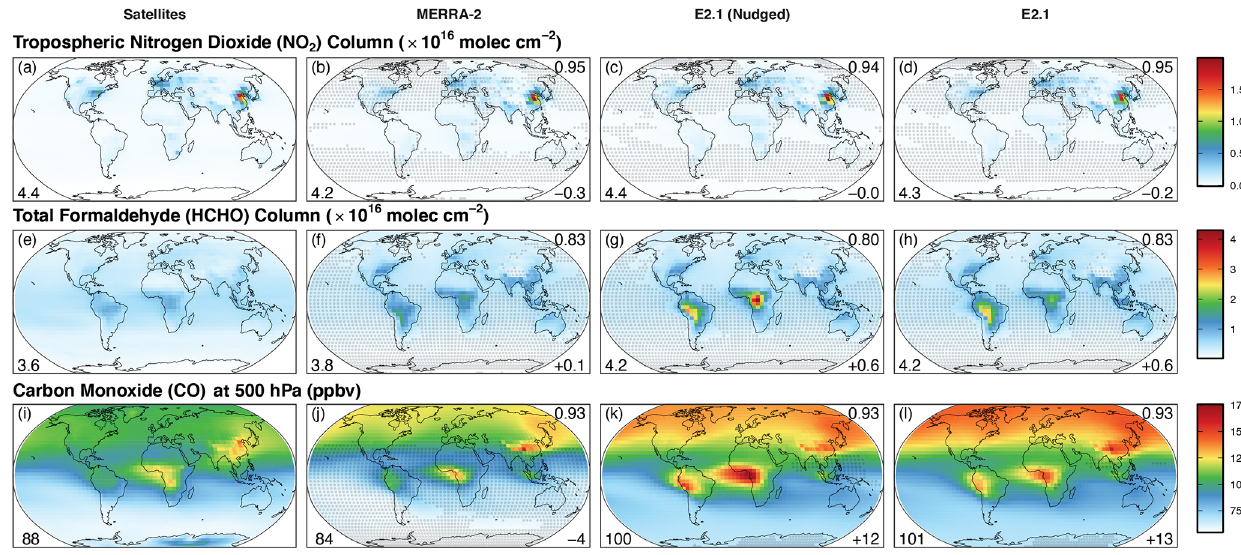
Figure 15. Annual average tropospheric columns of nitrogen dioxide (in 10 16 moleccm − 2 ; top row), total columns of formaldehyde (in 10 16 moleccm − 2 ; middle row), and carbon monoxide mixing ratio at 500hPa (in ppbv; bottom row) for 2005–2014CE. The left column from top to bottom shows the respective observations from OMI (Krotkov et al., 2017; González Abad et al., 2015) and AIRS (Tian et al., 2020). The three columns on the right show equivalent values determined from GEOS-Chem driven by MERRA-2, E2.1 nudged to MERRA- 2, and free-running E2.1 meteorology. Gray dots show locations where the simulated values are statistically different from the observations with respect to interannual variability ( p value < 0.05; n = 10 years). The number in the lower left of each panel shows the global mean value. The number in each model panel’s top right shows the pattern correlation ( R ) between the simulated and observed values. The number in the lower right shows the mean bias of the model with respect to the observations. The tropopause was determined in the simulations using the thermal lapse rate for comparison with satellite tropospheric